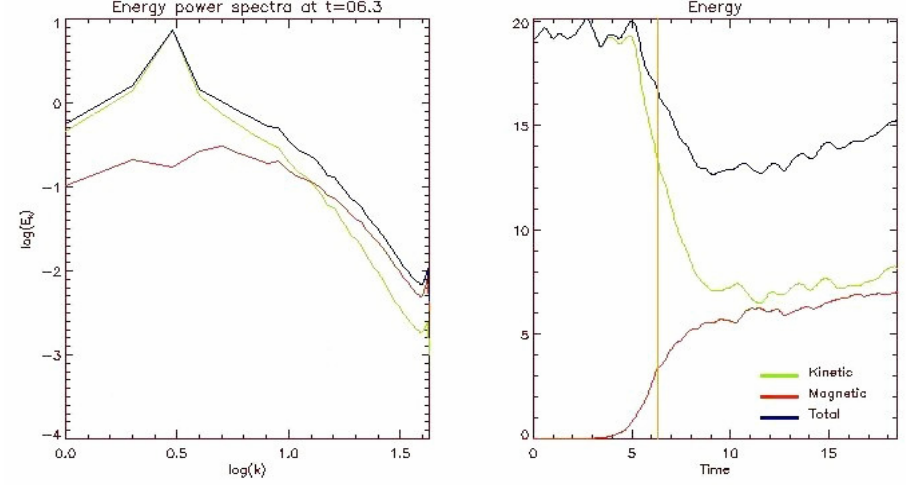
Figure 40: Still from a movie showing A 128 3 numerical simulation, as in Figure 35, but with an external force applied at wave number 𝑘 force = 3 (movie kindly provided by D. G´omez). (To watch the